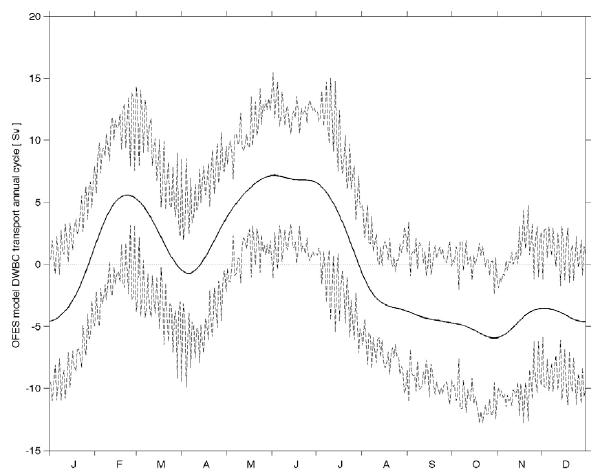
Fig. 10. Annual cycle of the DWBC transport calculated from the 27 Figure 10: Annual cycle of the DWBC transport calculated from the 27-years of OFES model output. Annual cycle was determined as a daily climatology that was smoothed yr of OFES model output. Annual cycle was determined as a daily with a 60-day 2 nd order Butterworth low pass filter. Dashed lines indicate plus and minus climatology that was smoothed with a 60-day 2nd order Butterworth two standard errors (95% confidence limits). low pass filter. Dashed lines indicate plus and minus two standard errors (95% confidence limits).